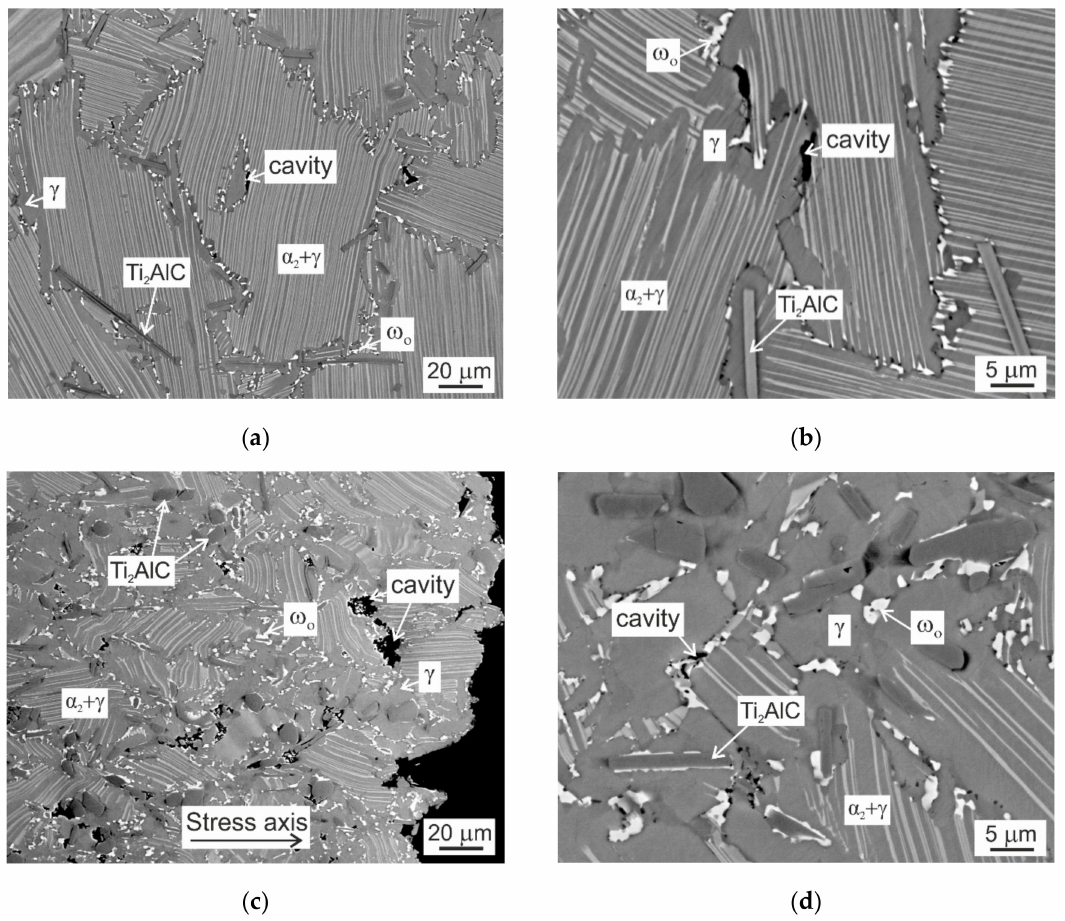
Figure 10. BSE micrographs showing longitudinal sections of C20 and C36 alloys after creep testing at a temperature of 800 ◦ C and applied stress of 200 MPa: ( a , b ) Microstructure of the C20 creep specimen tested to a strain of 6.2% for 1240 h; ( c , d ) Microstructure of the C36 creep specimen tested to a fracture for 610